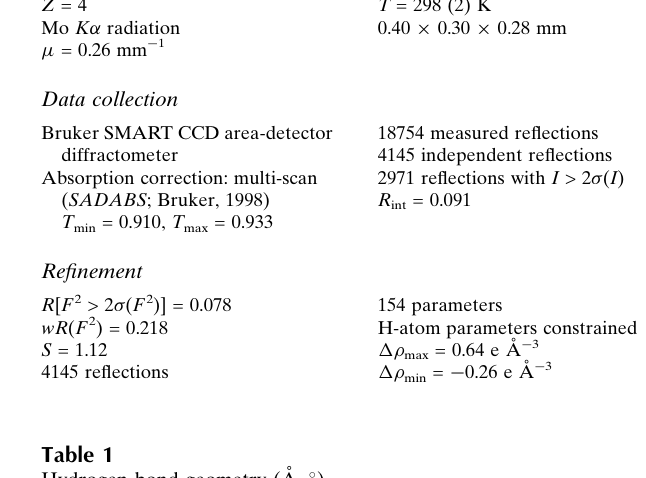
Hydrogen-bond geometry (A˚ , (cid:1)